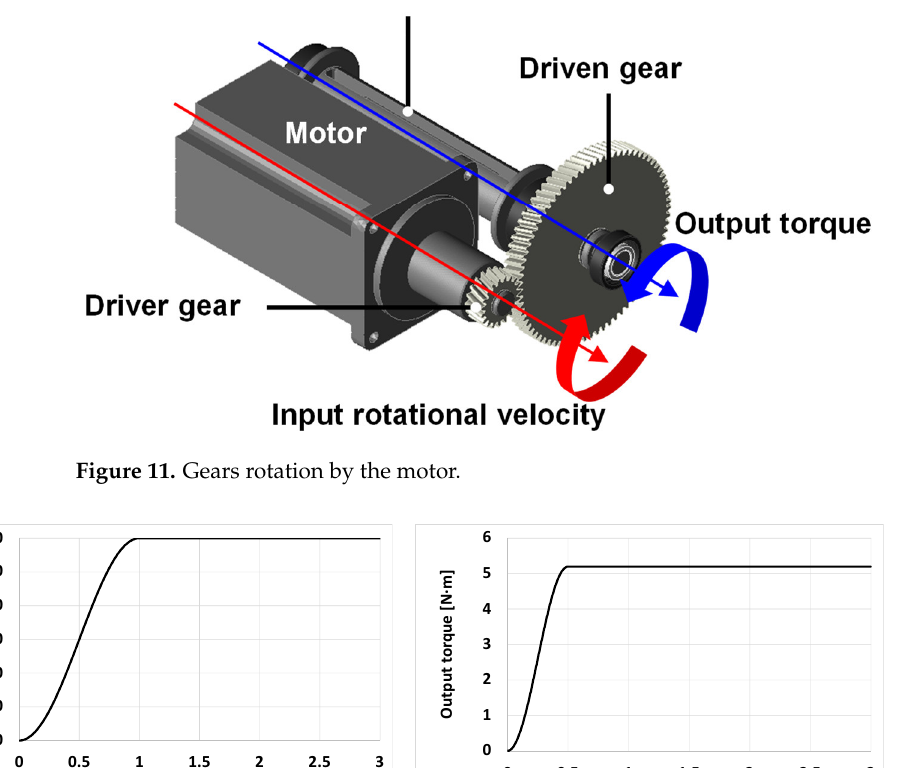
Figure 11. Gears rotation by the motor.